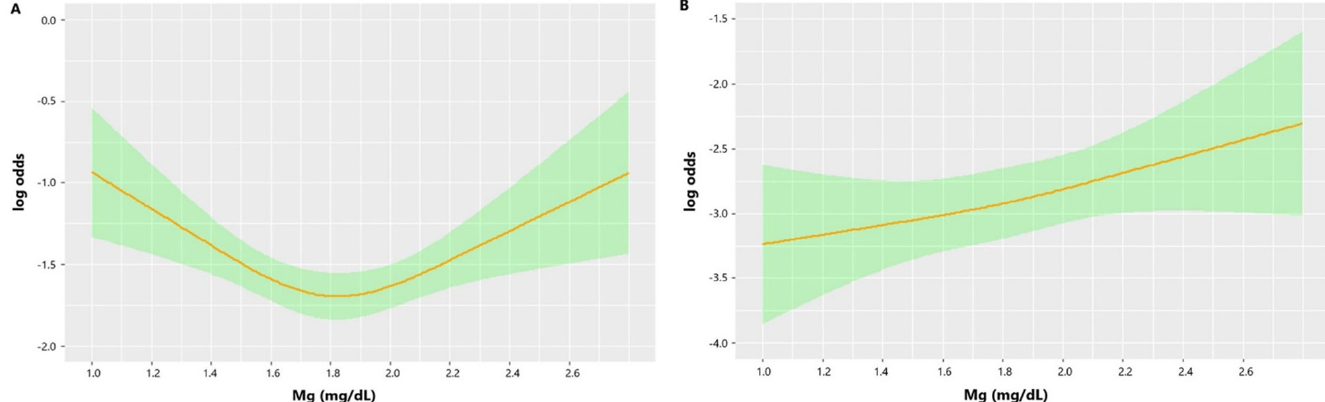
OR, odds ratio; CI, confidence interval; SpO 2 , pulse oxygen saturation; GCS, Glasgow Coma Scale; ISS, Injury Severity Score; WBC, white blood cell; RBC, red blood cell; RDW, red cell distribution width. Figure 4. Kaplan-Meier curve of survival analysis for three groups divided by serum magnesium level.